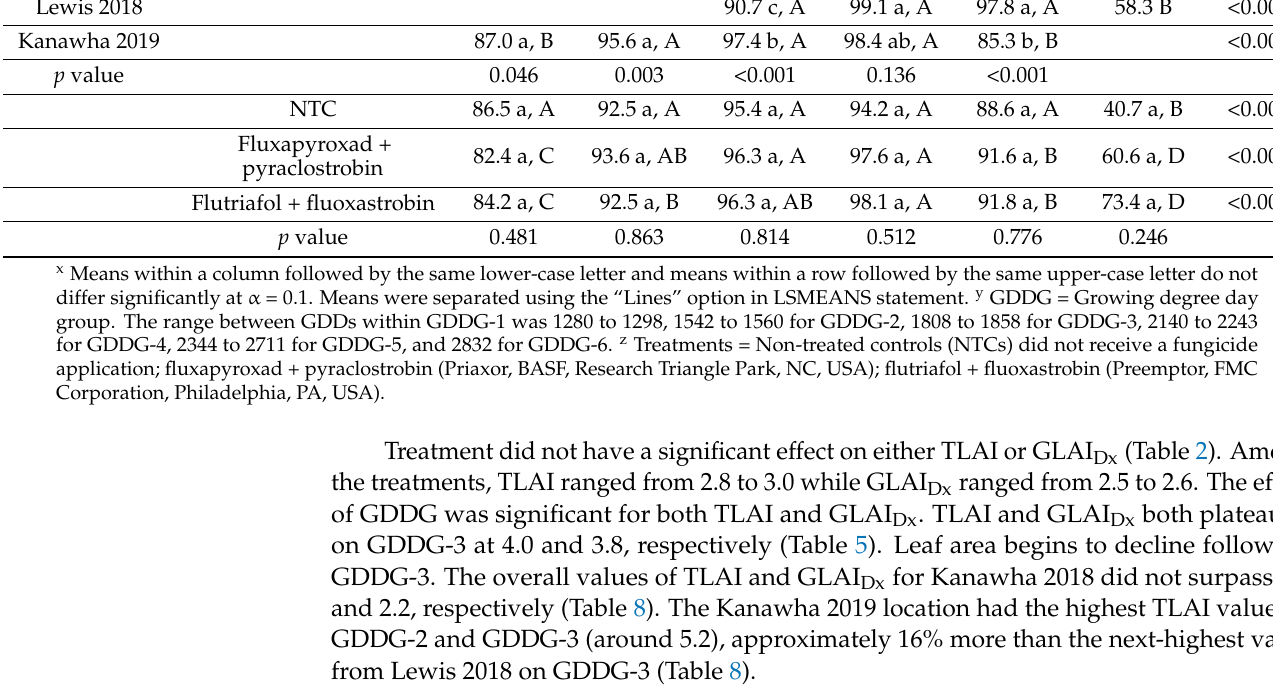
pyraclostrobin and flutriafol + fluoxastrobin treatments, respectively (Table 5). In general, the canopy cover peaked on GDDG-4 at 96.7% and decreased in following GDDGs (Table 5). The canopy cover for Kanawha 2018 was significantly less than that of Kanawha 2019 in GDDGs-1 and 2 (Table 7). Table 7. Least square means x of the canopy cover (CC) measured from experiments in Iowa during 2018 and 2019. CC y